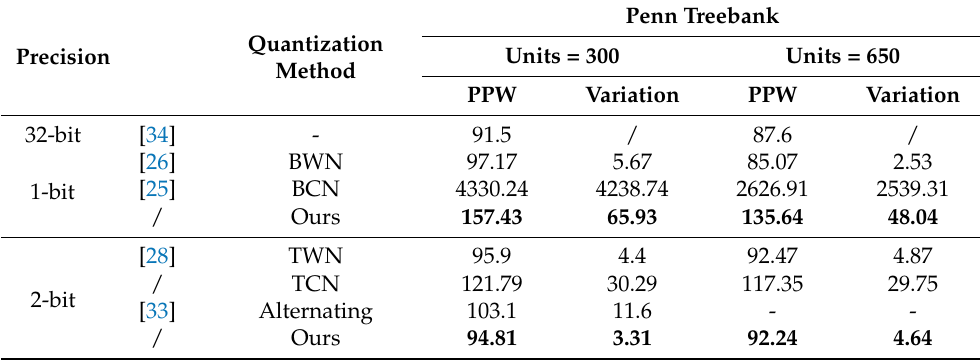
Table 4. Test PPW and variation of LSTM for word-level language modeling on Penn Treebank. Quantization Precision